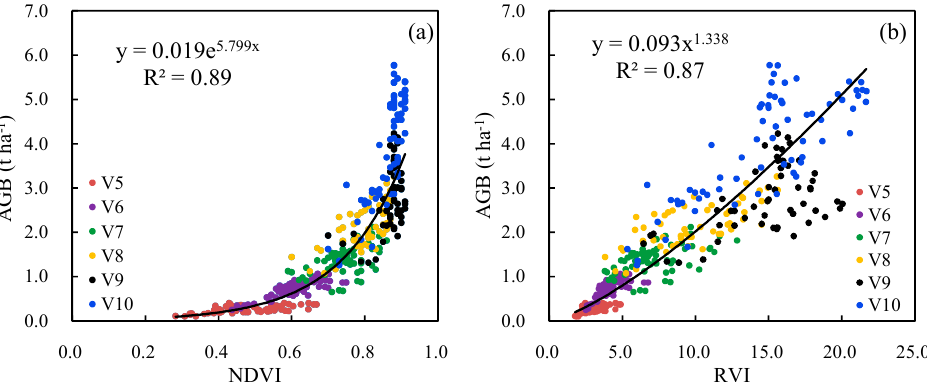
Figure 7. Relationships between aboveground biomass (AGB) and GreenSeeker sensor-based normalized difference vegetation index (NDVI) ( a ) or ratio vegetation index (RVI) ( b ) across V5 to V10 growth stage in 2014–2015.